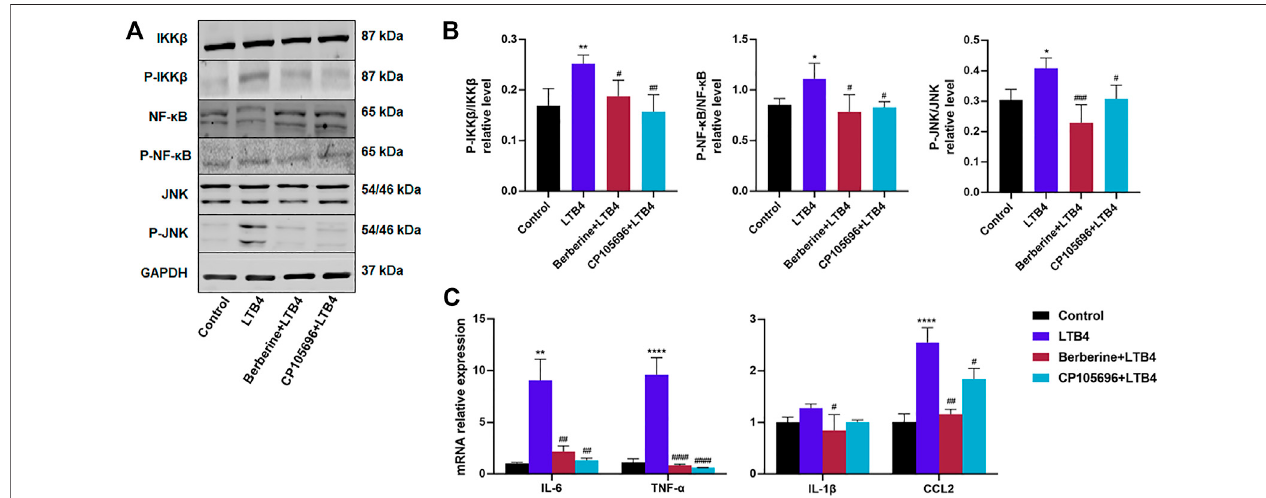
FIGURE3| BBRattenuatedthein fl ammation responseofRAW264.7 cellsinducedbyLTB4. (A) Westernblotsshowedtheprotein levels of p -JNK,p-NF- κ B,and p -IKK β in RAW264.7 cells (B) Densitometric analysis of p -JNK, p-NF- κ B, and p -IKK β in total protein was calculated ( n (cid:2) 4). (C) Gene expressions of IL-6, TNF- α , IL-1 β , andCCL2weredeterminedbyRT-PCR( n (cid:2) 3 – 4).Errorbarsrepresentmean ± SD.BBR,Berberine,10 μ M;CP105696,10 μ M;LTB4,LeukotrieneB4,200 nM* p <